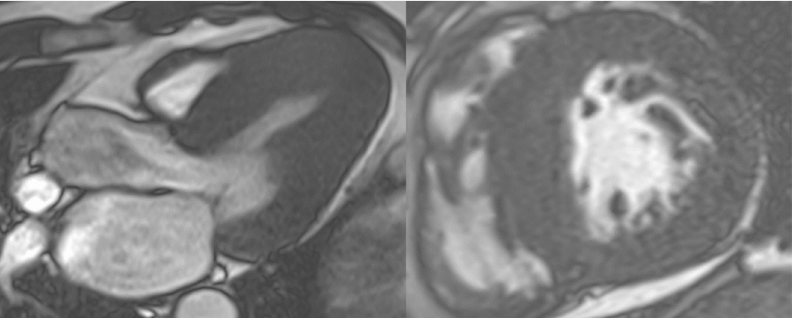
Figure 2. CMR cine imaging in a patient with Fabry cardiomyopathy; ( Left ) Apical 3-chamber view demonstrating concentric LVH with basal inferolateral wall-thinning; ( Right ) CMR short axis image demonstrating severe concentric